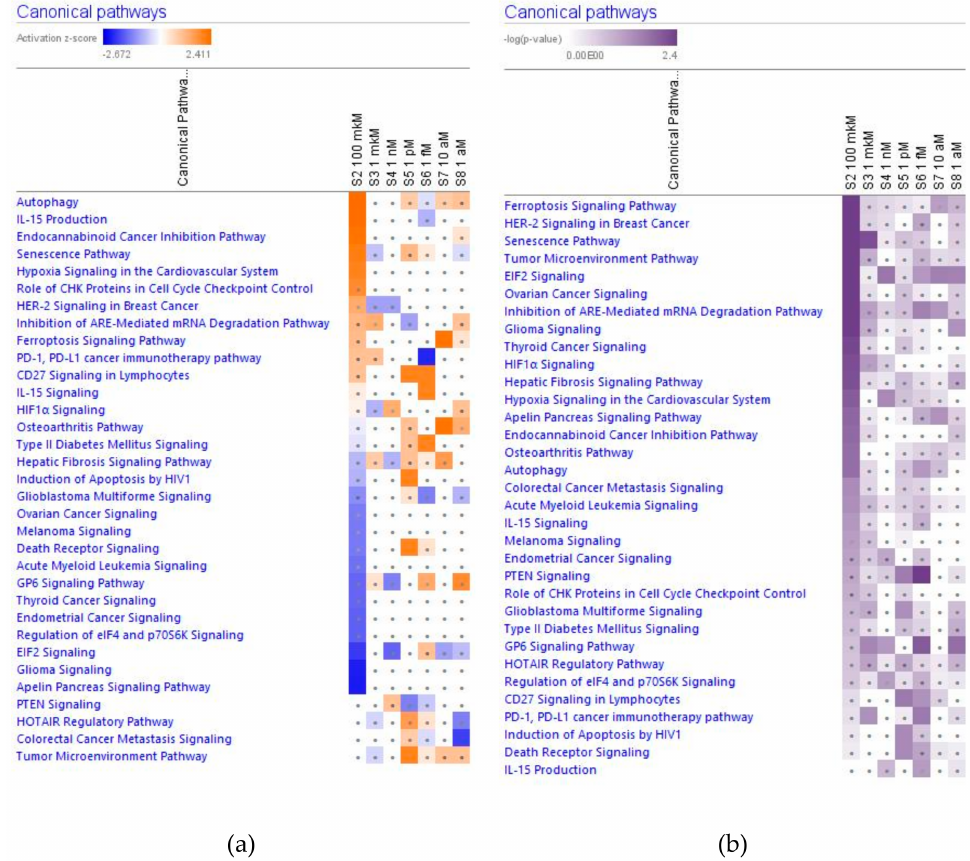
Figure 5. Effect of Rg5 in concentrations of 1 aM, 10 aM, 1 fM, 1 pM, 1 nM, 1 µ M and 100 µ M) on apoptosis and cancer (including death receptor signaling, programmed death PD-1 cancer im- munotherapy and tumor microenvironment) canonical pathways. ( a ) Brown color depicts predicted activation, blue color—predicted inhibition of signaling pathway; symbol shows that the activation z-score was <2. ( b ) Symbol shows that the − log p -value was